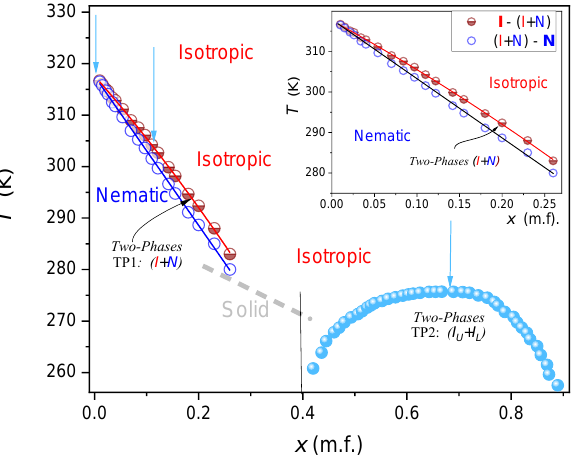
Figure 1. The phase diagram for n-(4-methoxybenzylidene)-4-butylaniline ( MBBA ) nematogenic LC and isooctane mixtures; concentrations are given in mole fractions of isooctane. Vertical arrows show paths of NDE studies in the isotropic liquid phase. The inset is focused on TP1 biphasic domain. Indices ‘ U ’ and ‘ L ’ are for the upper and lower coexisting phases, respectively.